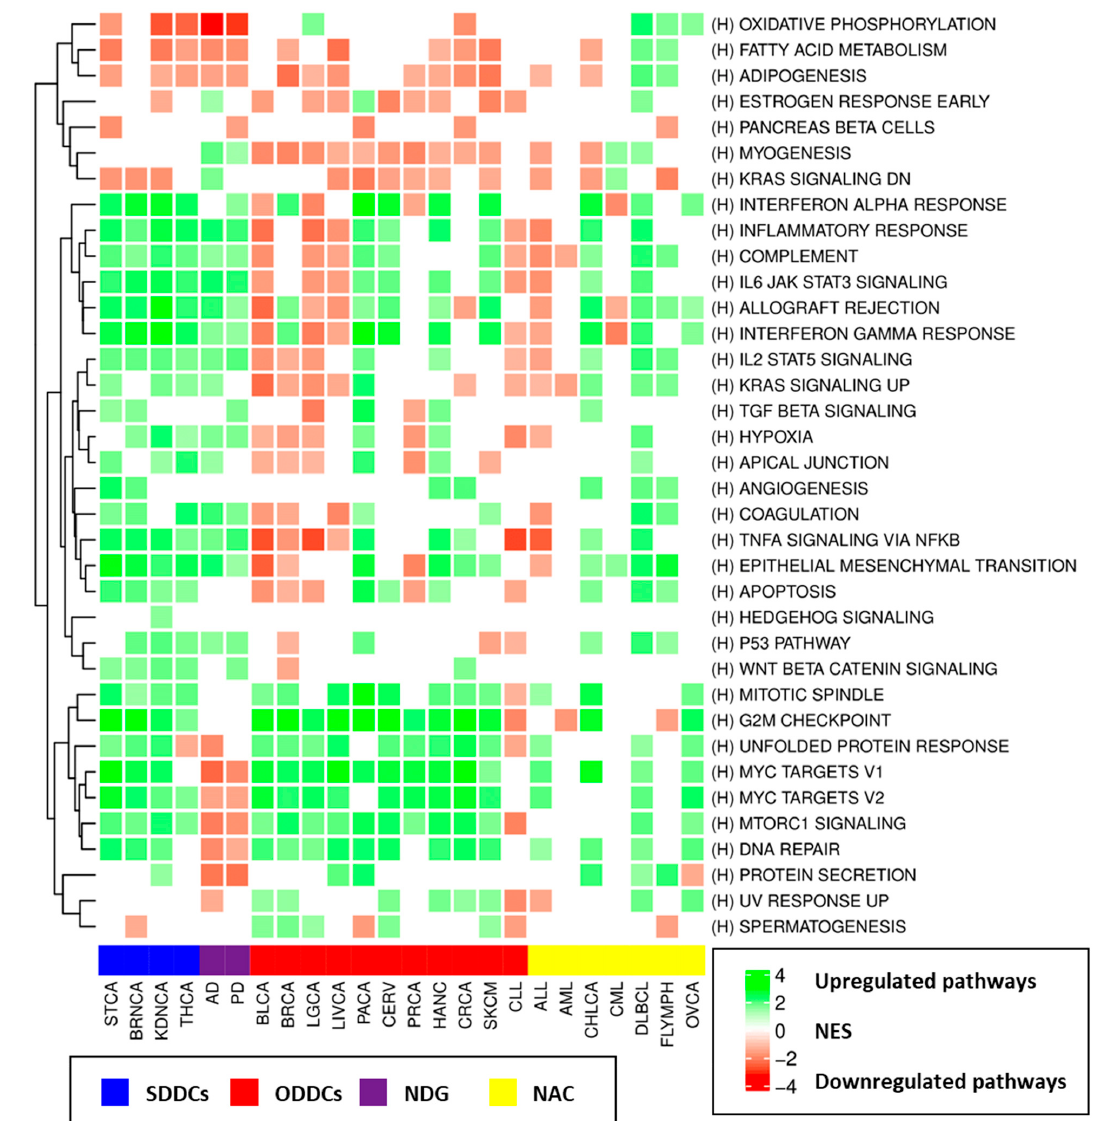
Figure 5. Hallmark molecular signatures in GSEA enrichment results for all studied disorders. Green and red cells indicate the upregulation and downregulation of pathways, respectively, with color intensity being proportional to NES values. Cancers showing direct (same direction) transcriptomic associations of deregulation with AD and/or PD (SDDCs) are coded in blue in the annotation bar below the heatmap, whereas cancers exhibiting inverse (opposite-direction) associations of transcriptomic deregulation with AD and/or PD (ODDCs) are coded in red. NDGs are annotated using purple. The yellow bar indicates cancers with no transcriptomic associations with AD or PD, termed as no associated cancers